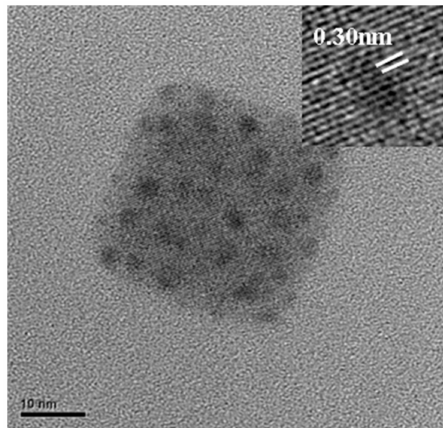
Figure 1. TEM image of the CsPbI 3 QD.